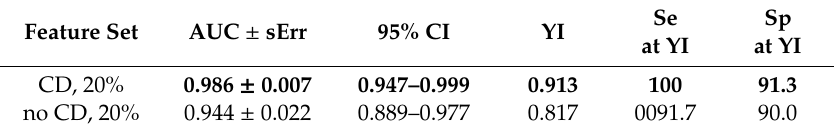
Table 4. Performance of models at 20% drop rate with